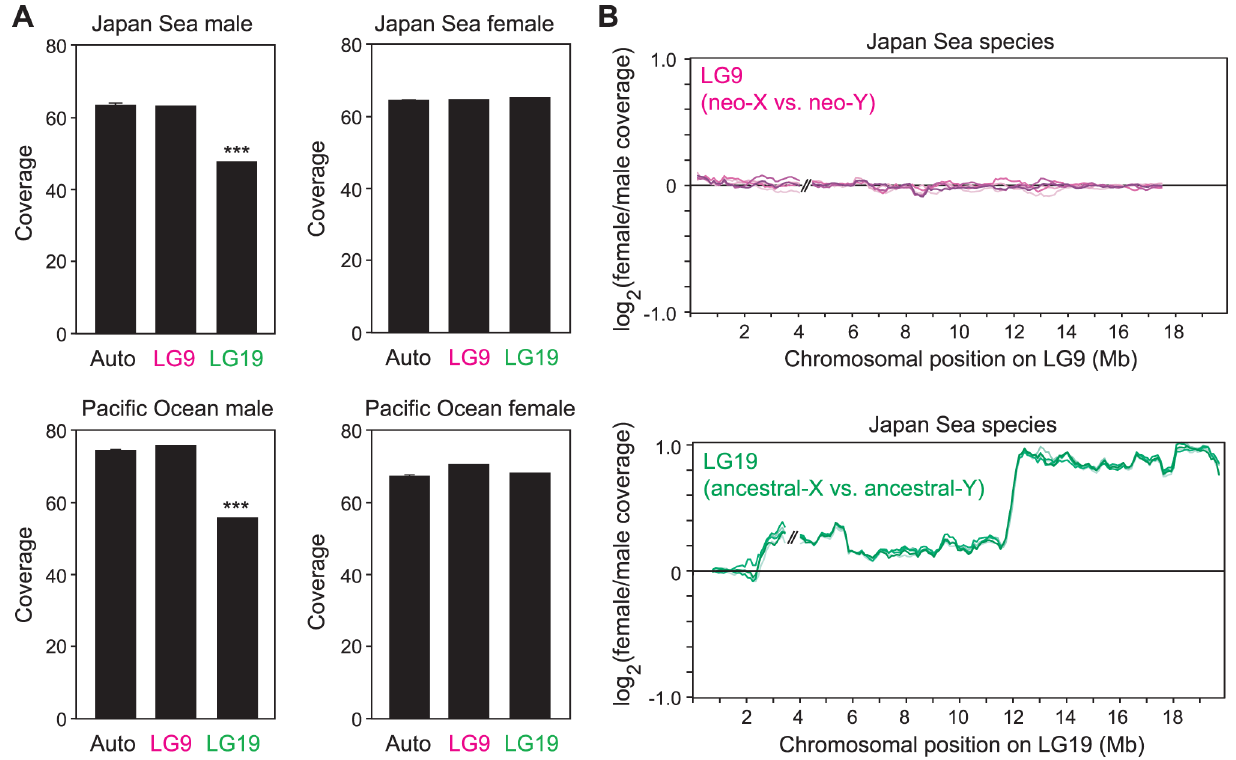
Figure 2. The absence of large-scale degeneration on the Japan Sea neo-Y chromosome. (A) Coverage of mapping of the reads was compared among LG9, LG19, and the autosomal linkage groups. For the linkage groups other than LG9 and LG19, means 6 S.E. are shown. A Grubbs’ outlier test was conducted to test whether LG9 and LG19 are outliers of all other linkage groups: ***, P , 0.001. Data from one representative male and one representative female of each species are shown here. (B) Sliding window analysis of differences in the coverage between Japan Sea males and Japan Sea females for LG9 and LG19. The window size and the step size were 500 kb and 100 kb, respectively. Because the order of the LG9 and LG19 sequence assembly is incorrect in the ensembl database [49,50], the locations of some supercontigs on LG9 and LG19 were inverted to provide the correct orientation (for details, see the Materials and Methods). Only the two largest supercontigs are shown here, and the gap between these two supercontigs is indicated by // in the figure. Different colored lines indicate different pairs of one Japan Sea male and one Japan Sea female (in total five independent pairs).